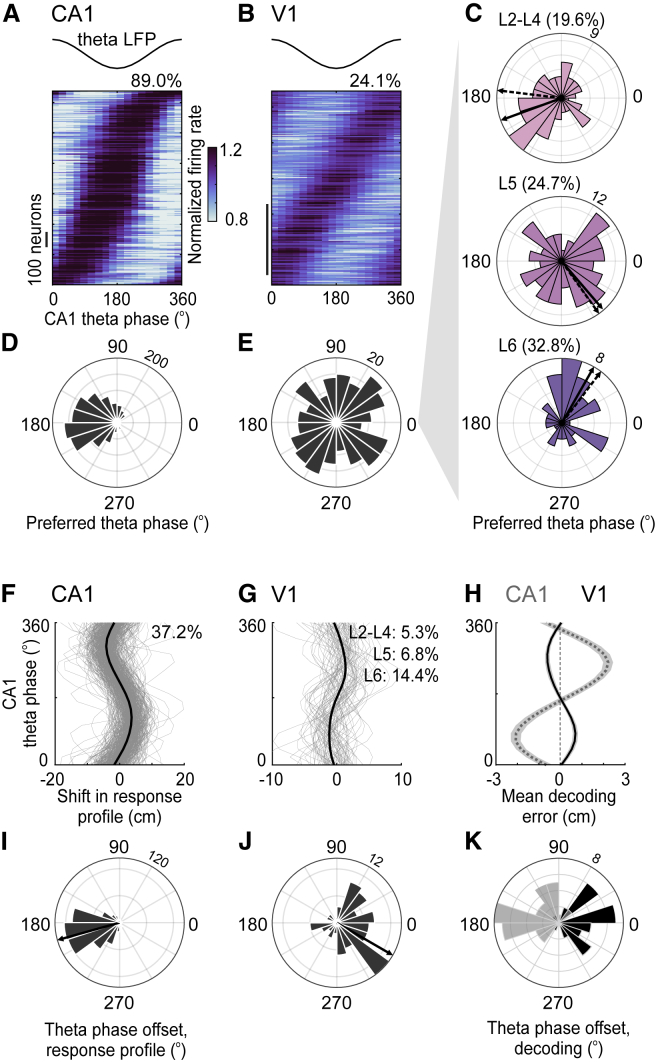
V1 Neurons Are Influenced by the Theta Oscillation Recorded in the Hippocampus(A) Firing rate of CA1 neurons as a function of the phase of theta oscillations recorded in hippocampus (top). Each neuron’s firing rate was normalized by its mean rate across phases. Neurons were ordered according to the theta phase of maximal firing. Only neurons with a significant modulation of firing rate across theta phase are represented (n = 1,274 out of 1,431; p < 0.05, permutation test).(B) Same as (A), for V1 neurons in relation to the theta oscillation measured in CA1 (n = 272 out of 1,127; p < 0.05, permutation test). See also Figure S4.(C) Distribution of the theta phase of maximal firing for V1 neurons recorded at different depths (L2–L4: 250–500 μm; L5: 500–700 μm; L6: 700–950 μm). Arrow indicates median of the preferred theta phase measured across neurons (solid) or across sessions (dashed).(D) Distribution of the theta phase of maximal firing for the CA1 neurons in (A).(E) Same for the V1 neurons in (B).(F) Spatial shift in response profiles across theta phases for CA1 neurons with a significant shift (gray curves: 37.2%, n = 1,431 neurons; p < 0.05, permutation test; black: average).(G) Same as (F) for V1 neurons with a significant spatial shift across theta phases (7.5%, n = 1,127 neurons; L6: 14.4% ± 2.9% (MAD), n = 188 neurons; L5: 6.8% ± 1.1%, n = 543 neurons; L2–L4: 5.3% ± 1.4%, n = 396 neurons, p < 0.05, permutation test). Note the smaller scale in (G) in relation to (F). See also Figure S4.(H) Mean error in population decoding from CA1 (gray) and V1 (black) as a function of the phase of the CA1 theta oscillation, averaged across sessions. Gray band shows ± SEM (CA1, n = 40 sessions; V1, n = 32 sessions).(I) Distribution of the theta phase offset (phase where the spatial shift went from positive to negative), for CA1 neurons with a significant spatial shift across theta phase. Arrow indicates median phase offset across all neurons.(J) Same as (I) for V1 neurons.(K) Distribution of the theta phase offset (phase where the decoding error went from behind to ahead) measured from the mean decoding error for each session, when decoding from CA1 (gray) and V1 (black).